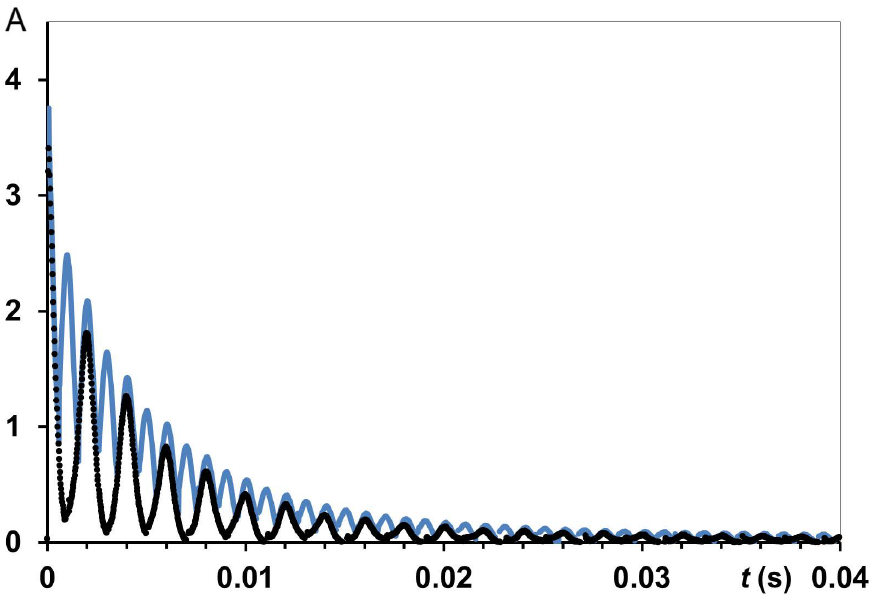
Figure 4. The CPMG pulse train echo intensity as a function of time ( t , s) measuring from 90 ◦ pulse for the silk fibres B. mori oriented along B 0 ; black circles: τ cp = 1 ms, echo is formed in every 2 ms; solid blue line: τ cp = 0.5 ms, echo is formed in every 1 ms; Dwell time (DW) = 10 µ s; NS = 512; HL = 0.60. A is the normalised amplitude of echo